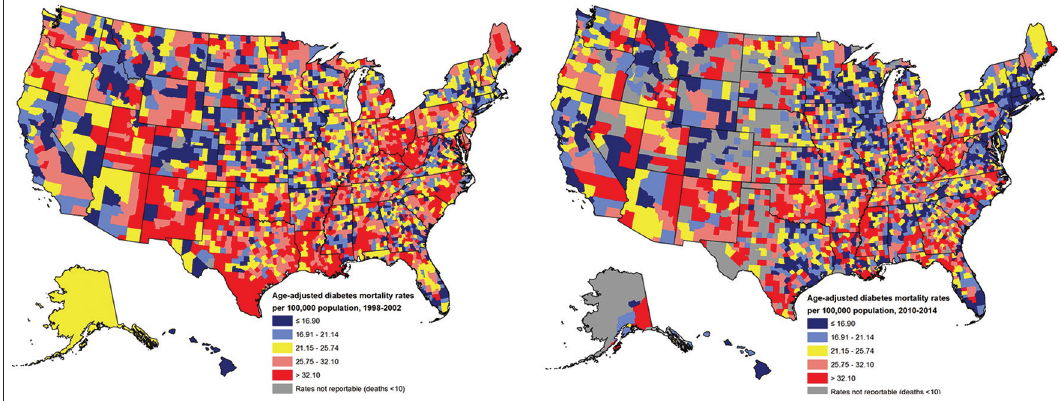
Fig ure 18. Age-Adjusted Diabetes Mortality Rates per 100,000 Population for the United States (3,143 Counties), 1998-2002 and 2010-2014 Source: Derived from the 1998-2014 National Vital Statistics System.